Question: Provide a one-line summary of what is displayed.
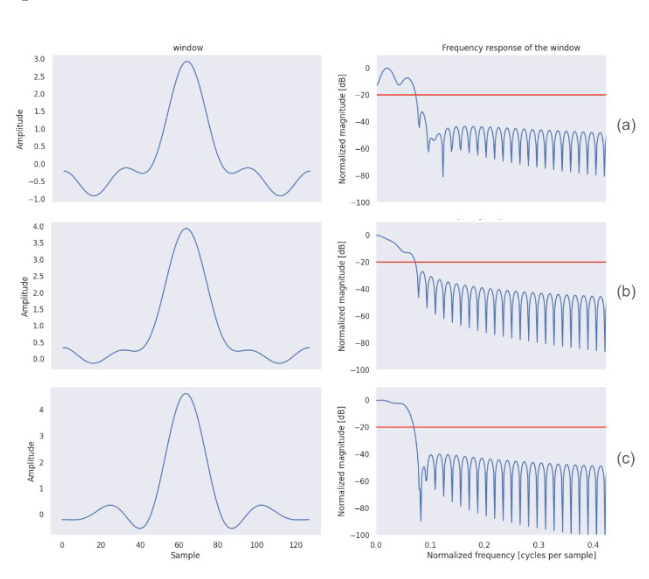
Answer: Comparison of Window Shape and Frequency Re- sponse of Filters from Different Bands. The chart displays the frequency response of low-range (a), mid-range (b), and high- range (c) frequency bands. The red line at -20dB represents the threshold at which noise is perceived as not noticeable.